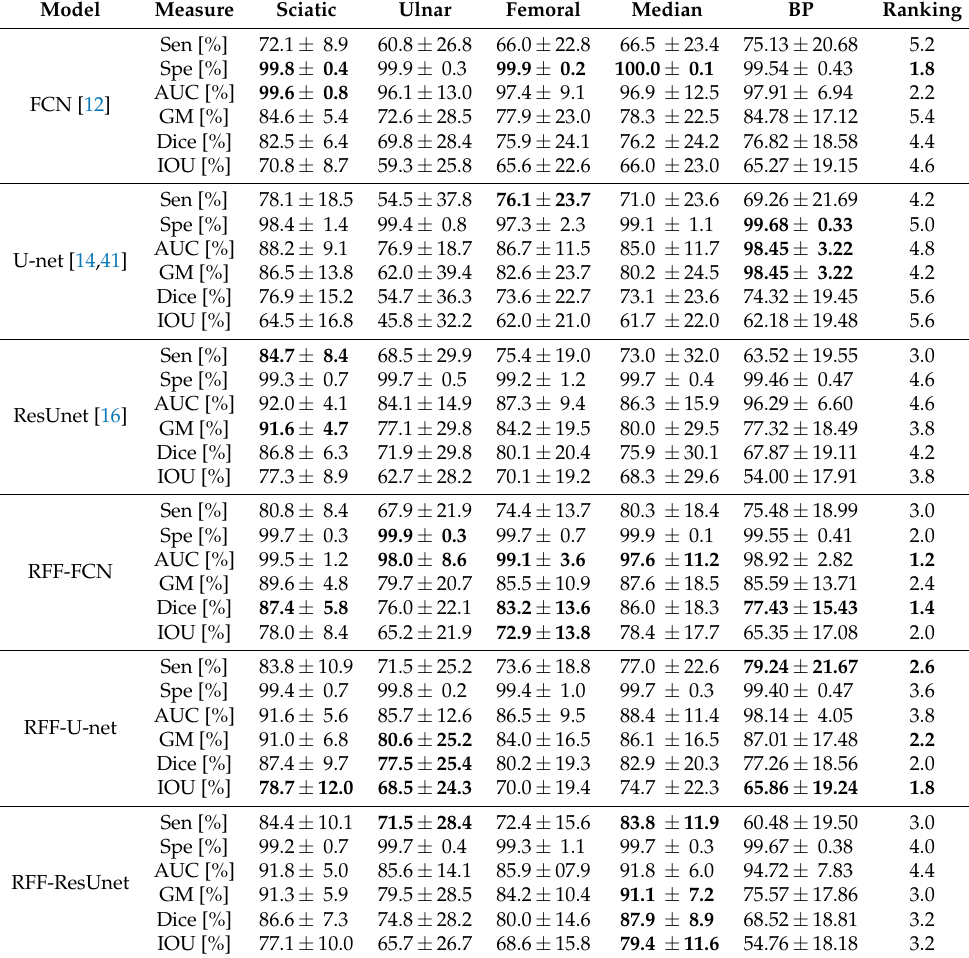
Table 1. Semantic segmentation results for nerve structure identification (the average along the testing set is reported for all provided measures). Bold: Highest performance among methods. Ranking stands for the average ranking from a Friedman statistical test. The sciatic, ulnar, femoral, and median nerve segmentation results are shown for the Nerve-UTP dataset. The brachial plexus (BP) results of the NSD dataset are also presented. FCN, U-net, ResUnet, and RFF-based enhancements (our approach) are presented. ˘ Q factor value equals 128, 64, and 8 for RFF-FCN, RFF-Unet, and RFF-ResUnet on Nerve-UTP’ nerves, and 128, 8, and 8 on NSD’s BP structure. Model Measure